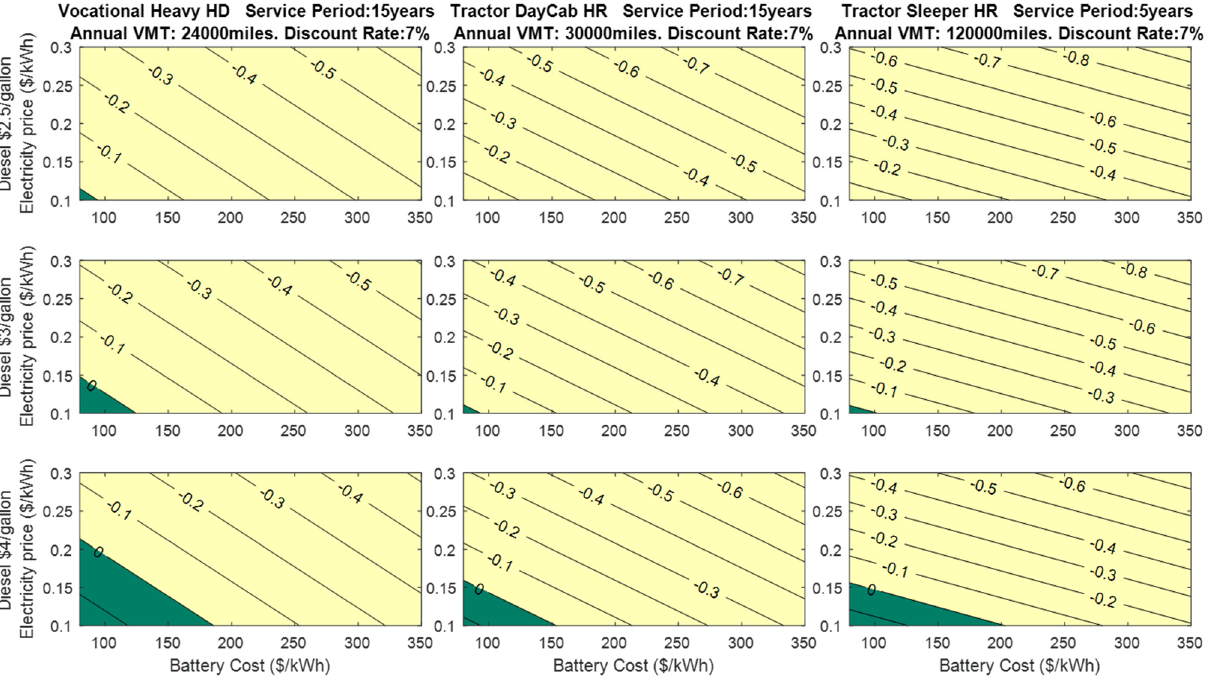
Figure 3. Difference in TCO in using an electric truck over a diesel truck for parcel delivery operations in urban centers.